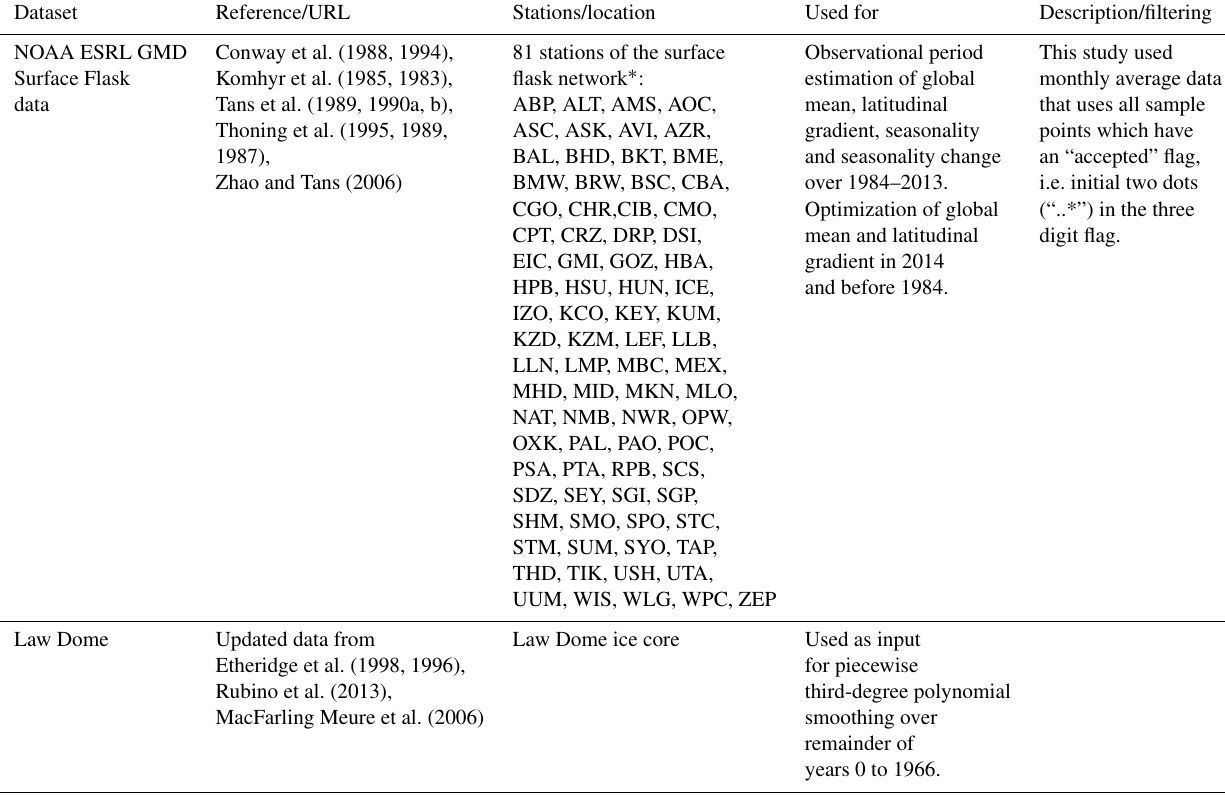
Table 2. Raw data used for CO 2 surface concentration field